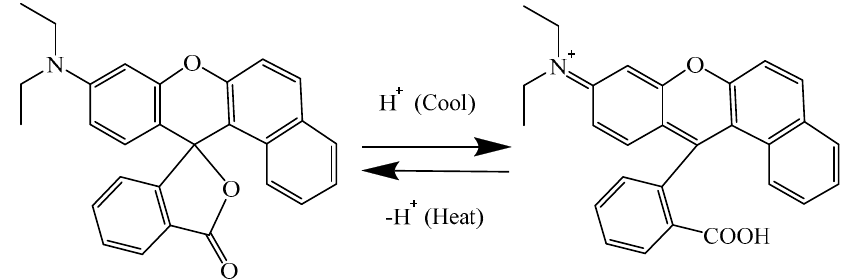
Figure 6. Discoloration principle of microcapsules.